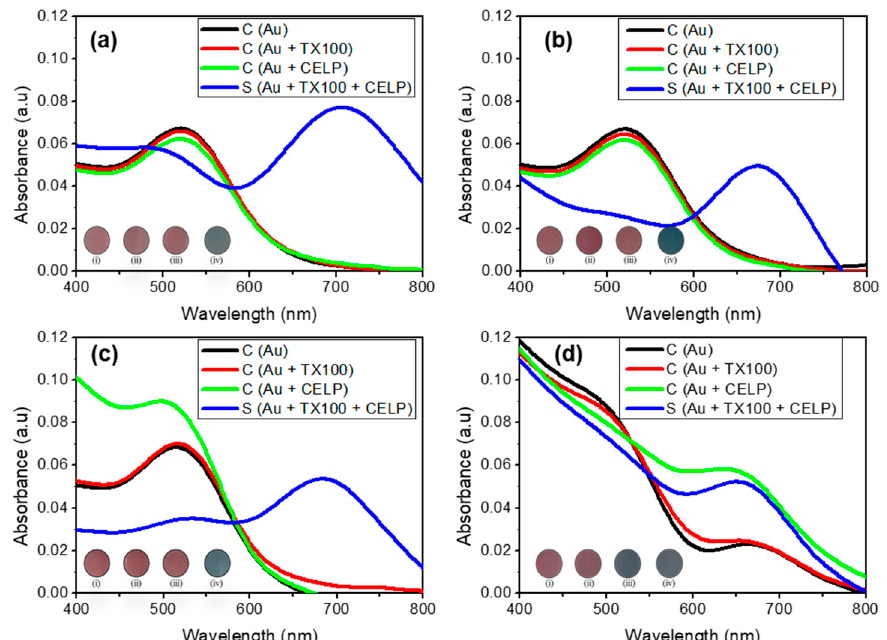
Figure 4. The UV–vis spectra of 0.12 mM AuNPs in various conditions and media: neutral pH ( a ), phosphate buffered saline (pH 7.4) ( b ), HCl-adjusted water (pH 5) ( c ), and phosphate buffer saline (pH 5.2) ( d ). Insets show the corresponding photographs of AuNPs: only AuNPs (i); AuNPs with TX100 (ii); AuNPs with CELP (iii); AuNPs with TX100 and CELP (iv).